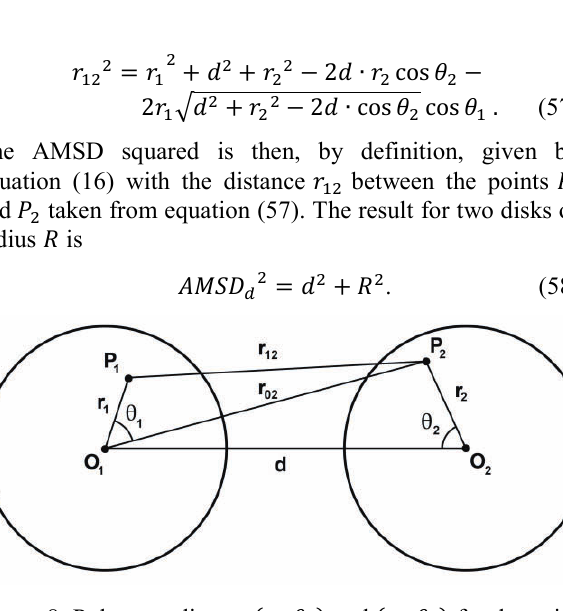
Figure 8: Polar coordinates ( ) and ( ) for the point in the cross section of the first wire and in that of the second.